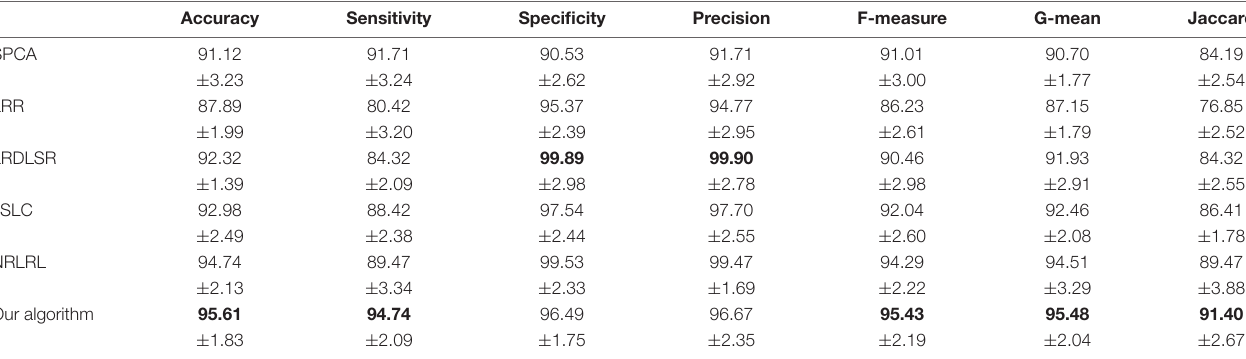
TABLE 2 | Classification results of the comparison algorithms in MCI and AD dataset.